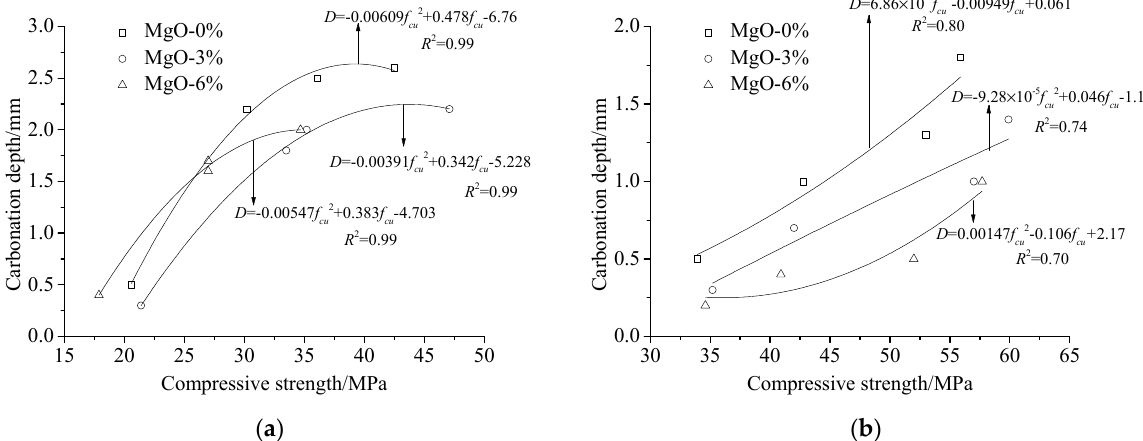
Figure 14. The relationship between carbonation depth ( D ) and compressive strength ( f cu ): ( a ) C30; ( b ) C50.